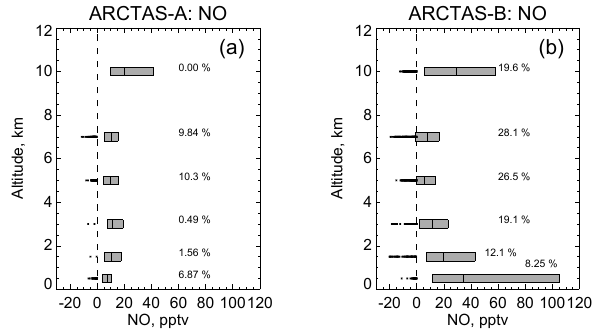
Fig. 2. Range of NO observations during (a) ARCTAS-A and (b) ARCTAS-B for 1-min averages of NO. Bars show the inner 50th percentile range (25–75%) and vertical lines within bars indicate the median values. Negative values are shown with black points to the left of the dashed line that indicates zero. The percentage of negative values is indicated at each altitude